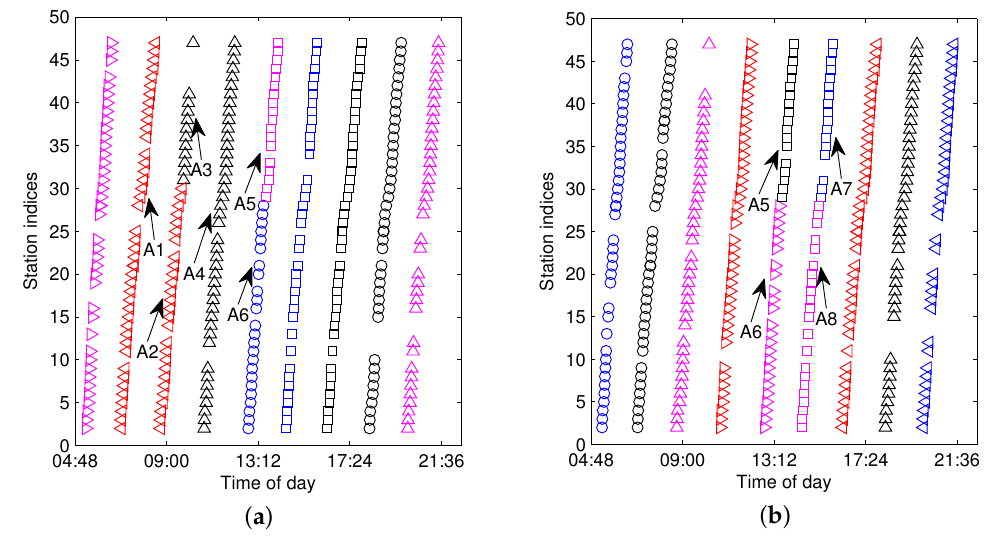
Figure 12. The comparison of FCM with different settings of c . ( a ) a = 2, c = 9; ( b ) a = 2, c = 11.